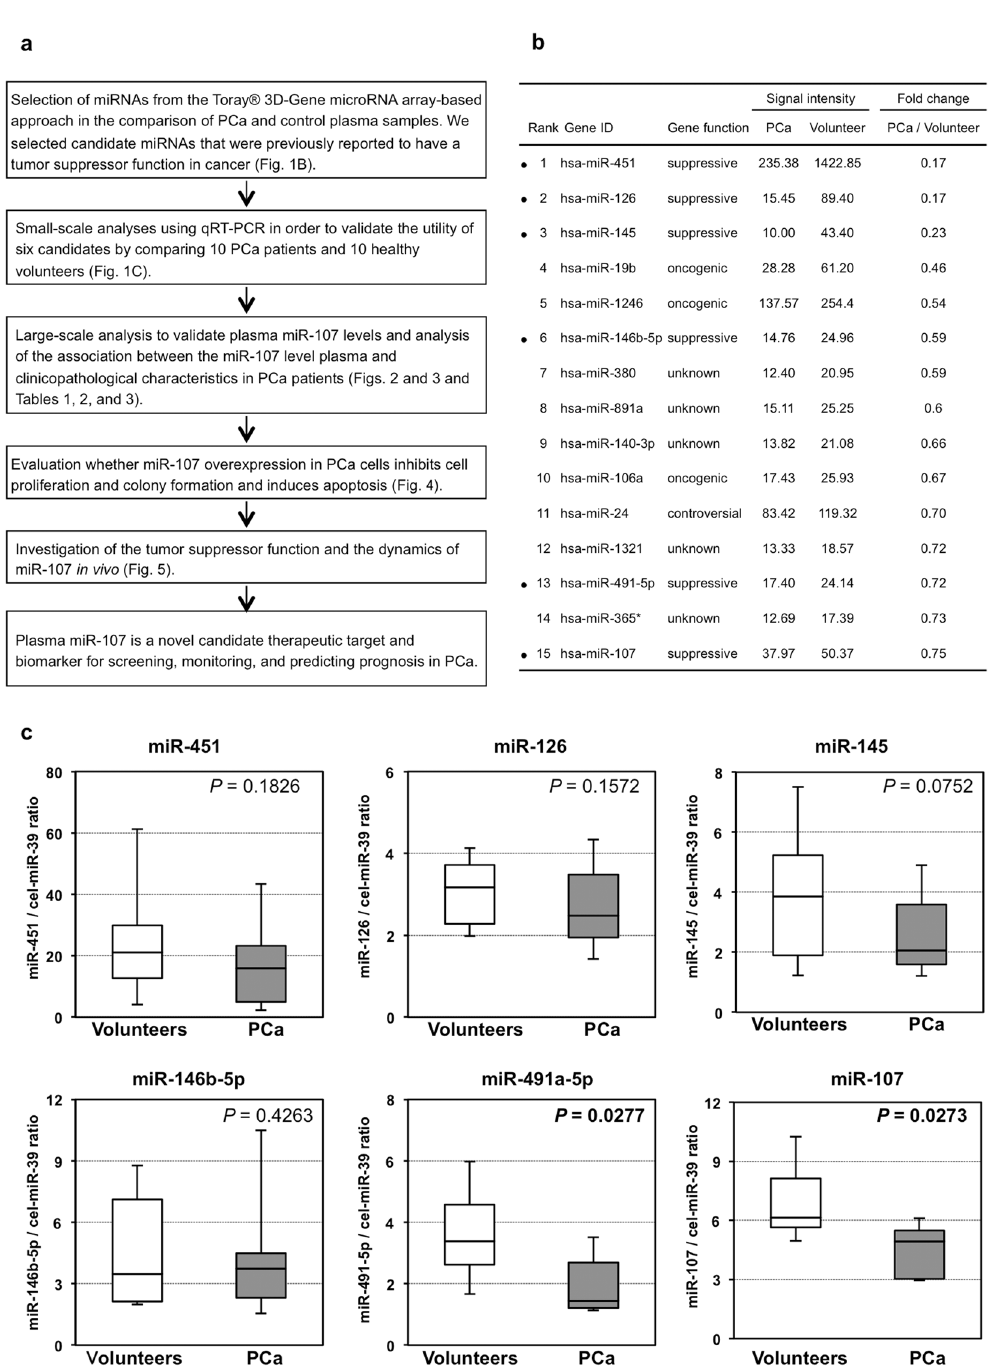
Figure 1. Study design and Selection of plasma miRNA candidates. ( a ) Study design to find novel candidate miRNAs that decreased in patient plasma as a therapeutic target for PCa. ( b ) Using a miRNA array-based approach, we found decreased plasma miRNAs with tumor suppressor functions by comparing the plasma levels of each miRNA between PCa patients and healthy volunteers. ( c ) Small-scale analysis of the plasma levels of six miRNAs in PCa patients and healthy volunteers by qRT-PCR. We investigated the plasma levels of the six selected miRNAs in 10 PCa patients and 10 healthy volunteers by qRT-PCR. The miRNA array-based approach showed that all six candidate miRNAs tended to be lower in the plasma of PCa patients than in that of healthy volunteers, and the change in the expression of miR-107 ( P = 0.027) was found to be the most